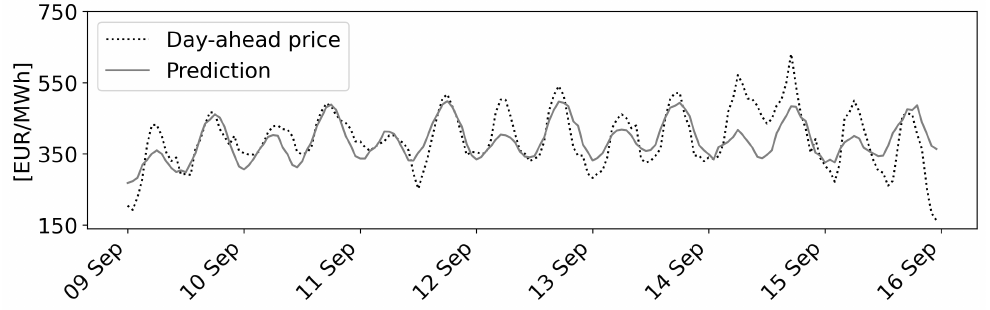
Figure 10. LSTM prediction for test scenario